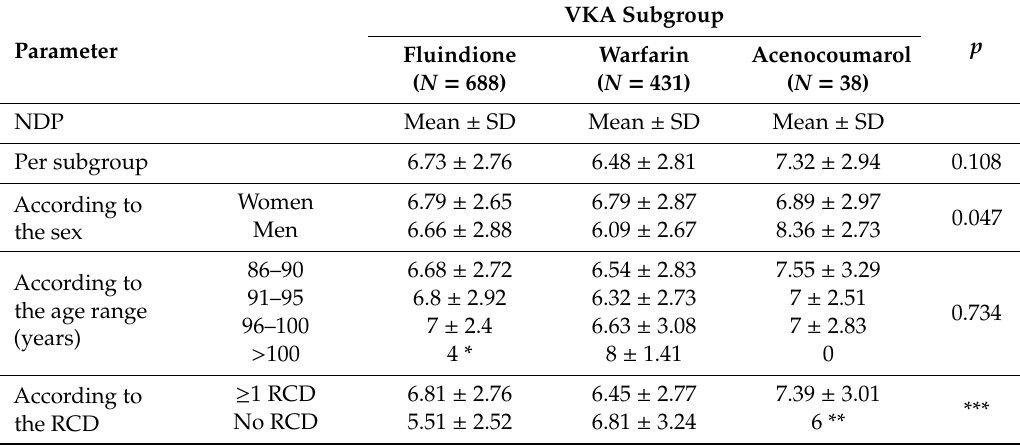
Table 4. Comparison of number of drugs per prescription (global, according to the gender, age range, and registered chronic diseases) in the three subgroups of vitamin K